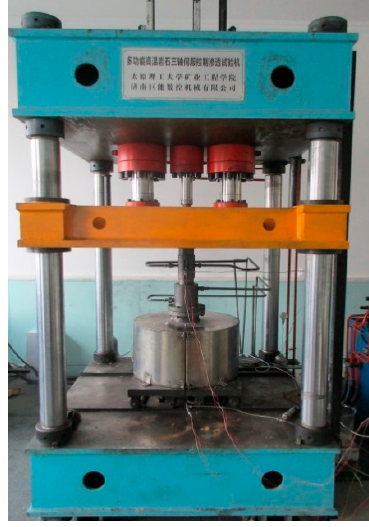
Figure 2. Multi-Functional rock high temperature triaxial testing machine.